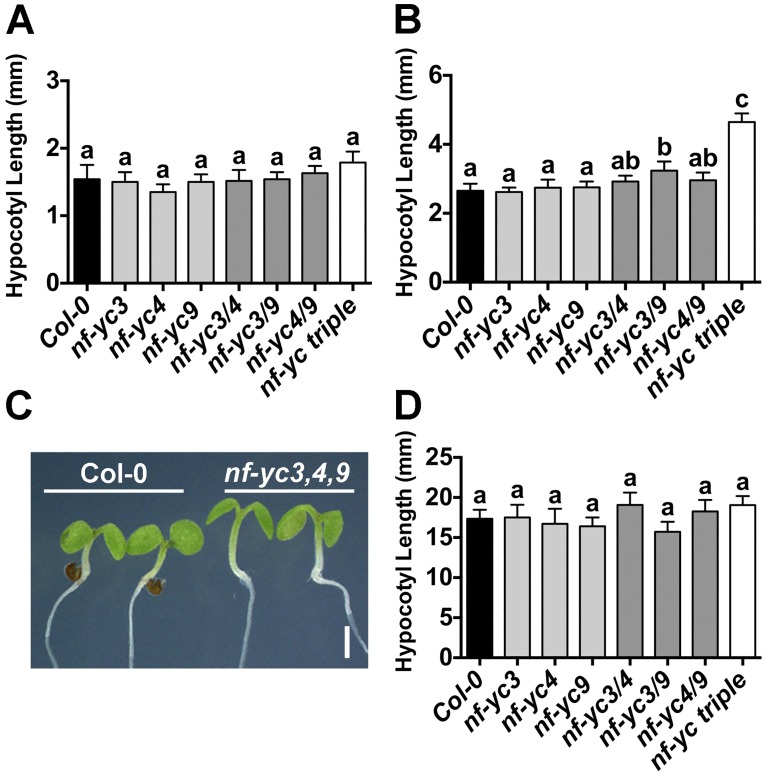
NF-YC3, 4, and 9 contribute redundantly to suppression of hypocotyl elongation in white light.Hypocotyl lengths are shown for plants grown for five days on B5 media in A) cWL, B-C) SD, or D) cD conditions. No differences were detected at earlier time points in cD-grown plants. Statistically significant differences (or lack thereof) are represented by lettering above bars (error bars represent 95% confidence intervals). Statistical differences were determined by ANOVA (P<0.01) and subsequent multiple comparisons by either Tukey’s (cWL) or Dunnett’s (SD, cD) procedures. Scale bar in C) represents 2mm.